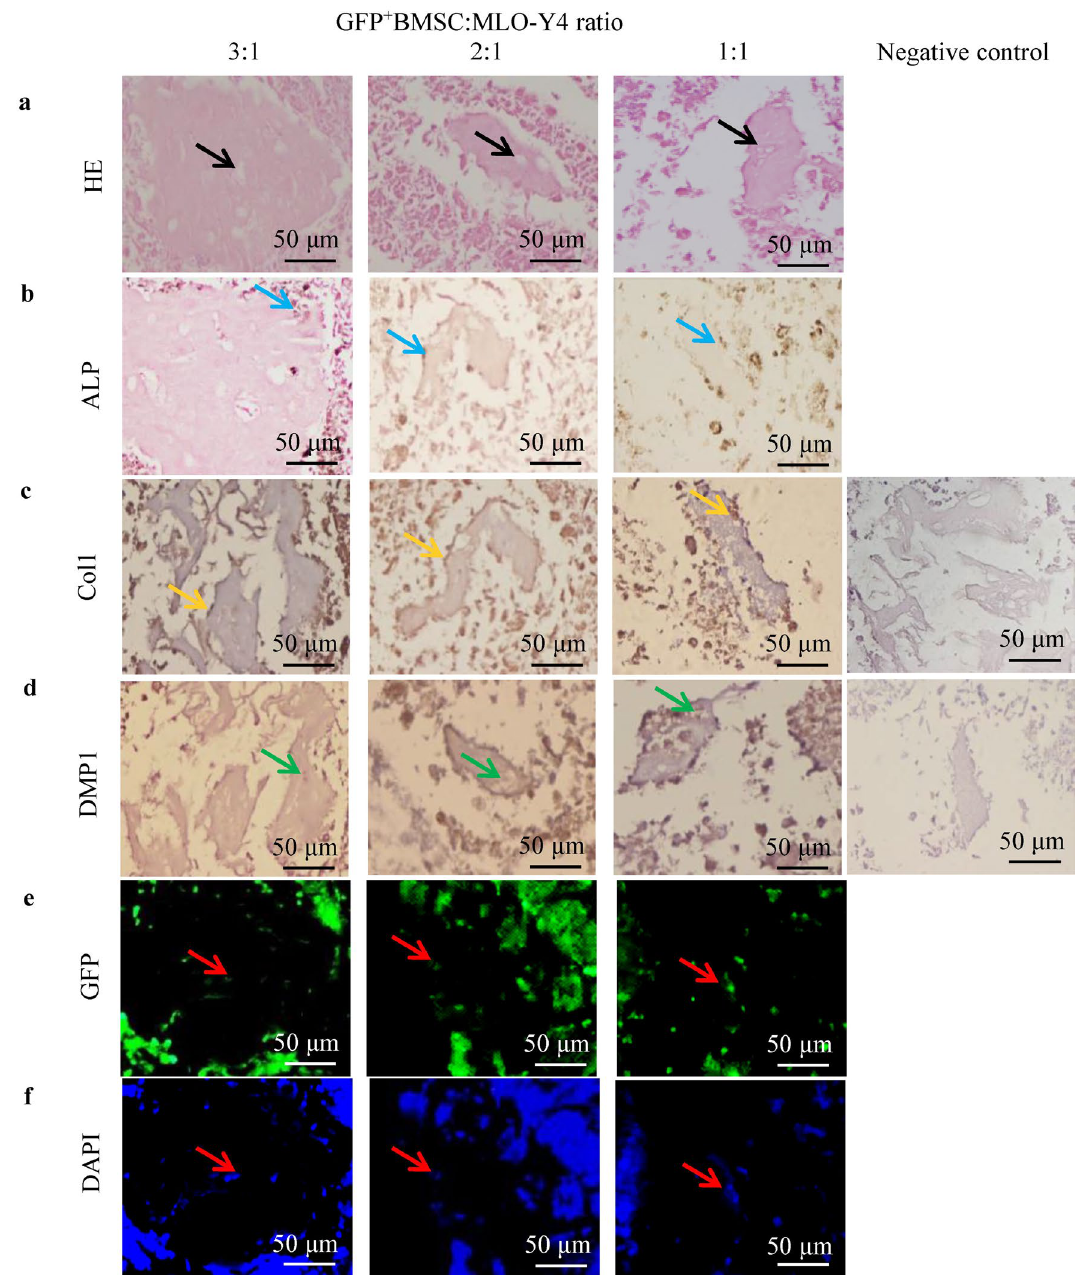
Figure 3. The histomorphological and immunohistochemical features of the bone-like tissues. ( a ) HE staining showed osteoblast-like cells surrounded by a cohesive osteoid-like matrix and osteocyte-like cells embedded into lacunae-like structures (black arrowheads) in the 3:1, 2:1, and 1:1 co-cultures. ( b , c ) Osteoblast-like cells on the osteoid-like matrix surface were positive for ALP (blue arrowheads) and Col1 (orange arrowheads). ( d ) Osteocyte-like cells in the osteoid-like matrix were positive for DMP1 (green arrowheads). ( e , f ) Fluorescence microscopy showed that osteocyte-like cells embedded in the osteoid-like matrix and osteoblast-like cells on the surface were GFP positive (red arrowheads). DAPI, 4 ′